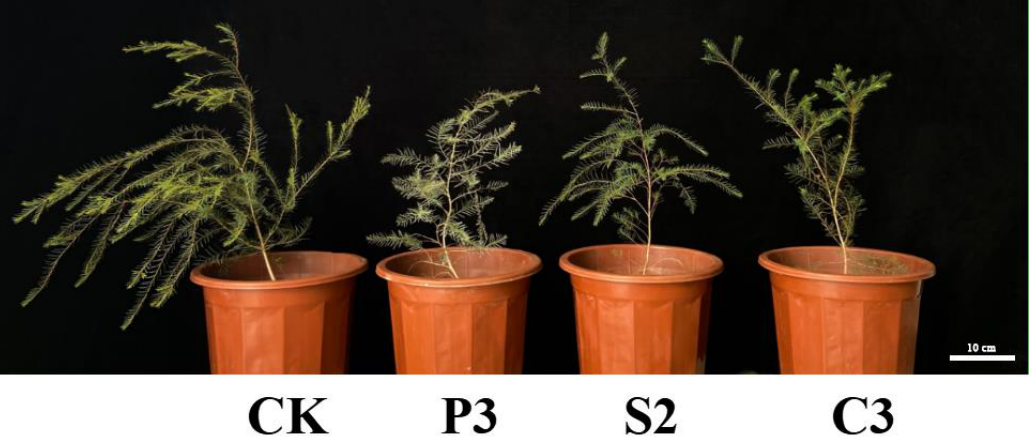
Figure 2. Comparison between CK and the treatment with the most obvious influence on plant height of each PGRs.CK: treated with water, P3: treated with 2000 mg·L −1 PP333, S2: treated with 100 mg·L −1 S3307, C3: treated with 3000 mg·L −1 CCC, the same below.